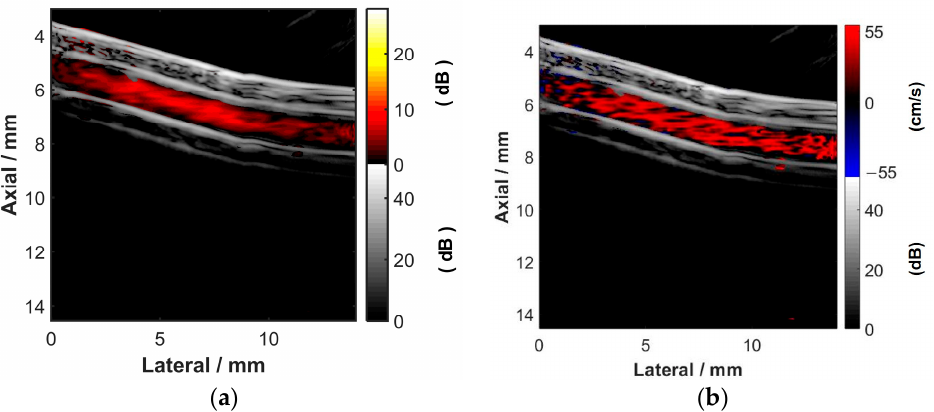
Figure 16. The fused color flow imaging results of the blood flow phantom with B-mode image of ( a ) power Doppler image and ( b ) color fl ow Doppler image.